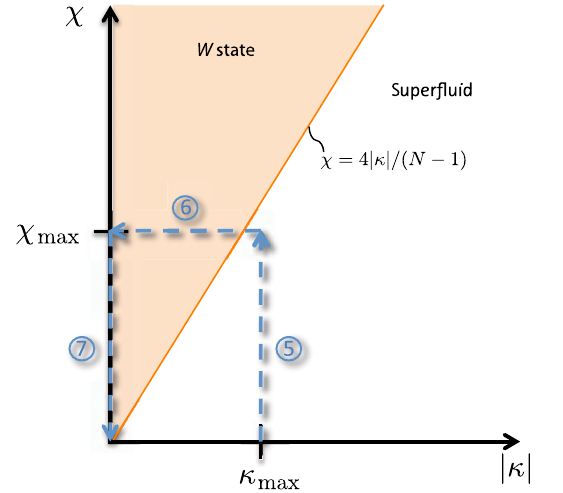
FIG. 4. Approximate phase diagram corresponding to the ABH of Eq. (1). The intermediate phase is not shown. Dashed blue arrows indicate the last three steps of the entanglement protocol.